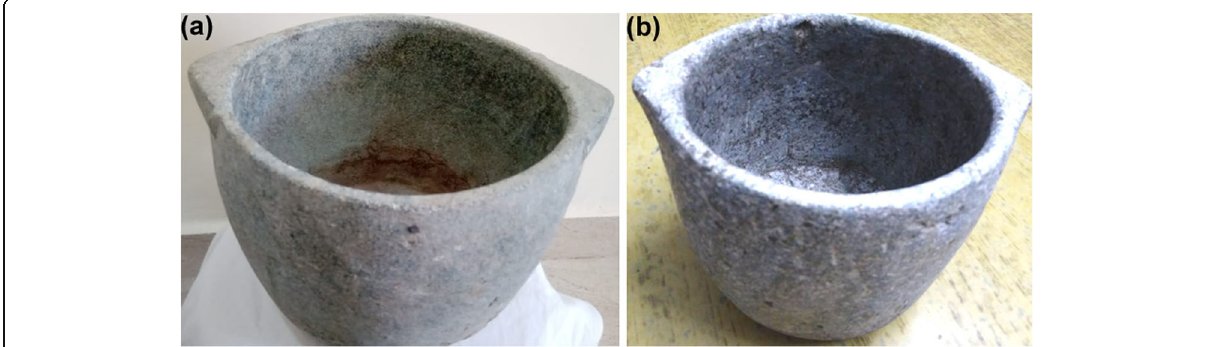
Fig. 4 Century old soapstone vessels/ rathi chippa inherited from generations and extensively used for a cooking gongura pulusu and b storing